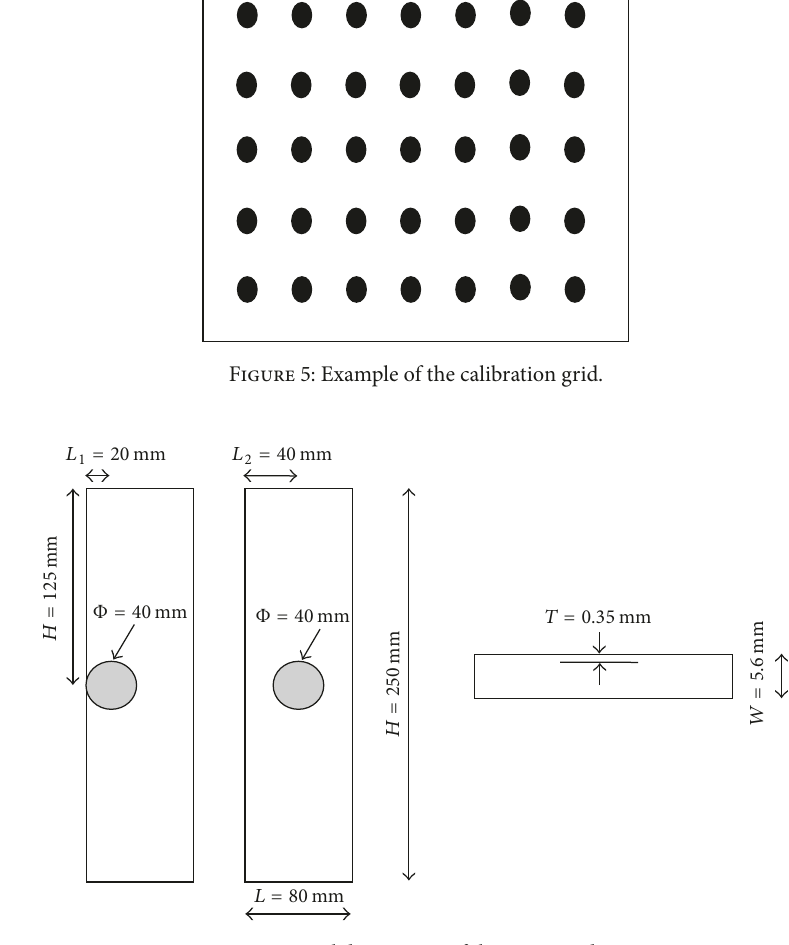
Figure 6: Geometrical description of the two tested specimens.